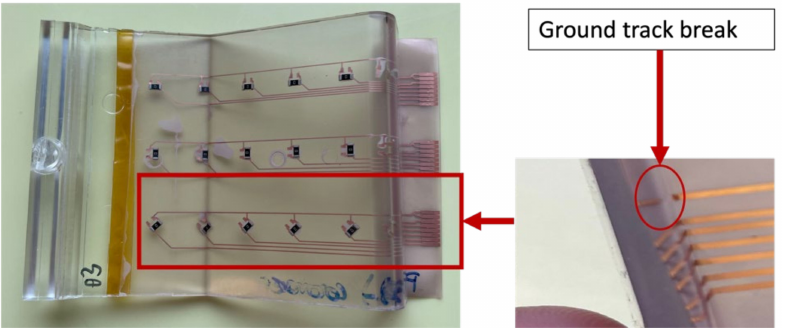
Figure 44. Ground track break in the corner mold in foil